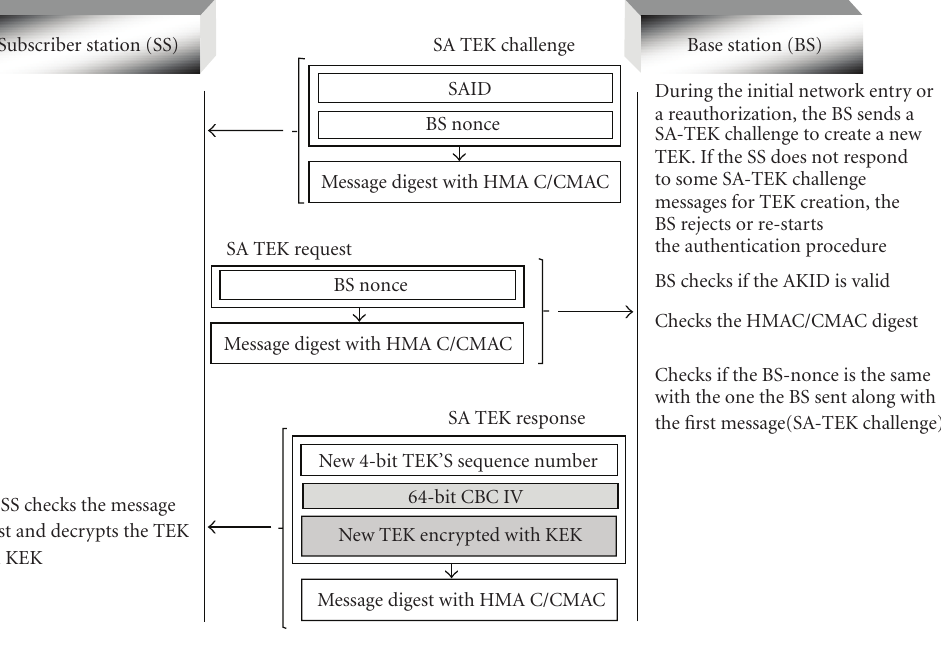
Figure 17: SA-TEK 3-way handshake with PKM v.2.